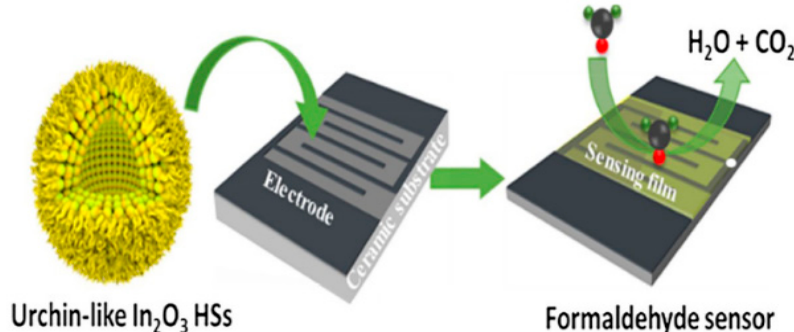
Figure 6. Process of sensor preparation by drop coating method [56].